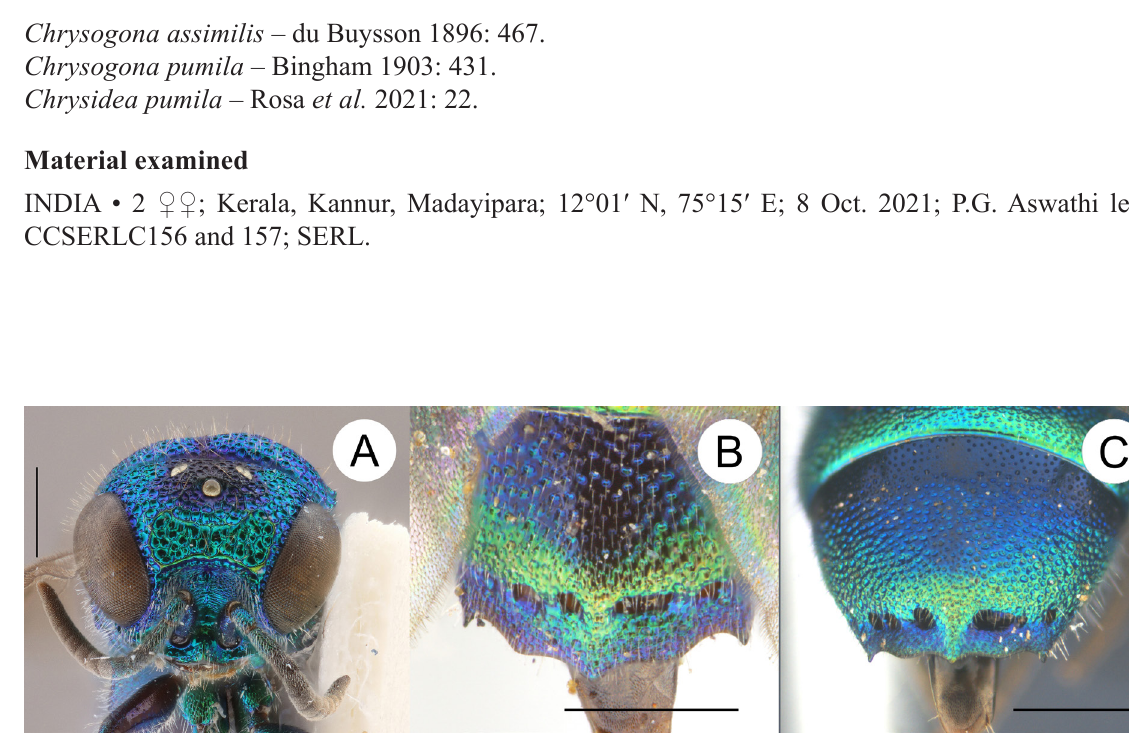
Fig. 9. A . Chrysidea furiosa , ♀, (RMNH), head in frontal view. B . Chrysidea mendicalis , ♀, holotype (OUMNH), apex of T3 in dorsal view. C . Chrysidea falsa , ♀, holotype (SCAU), apex of T3 in dorsal view. Scale bars: 0.5